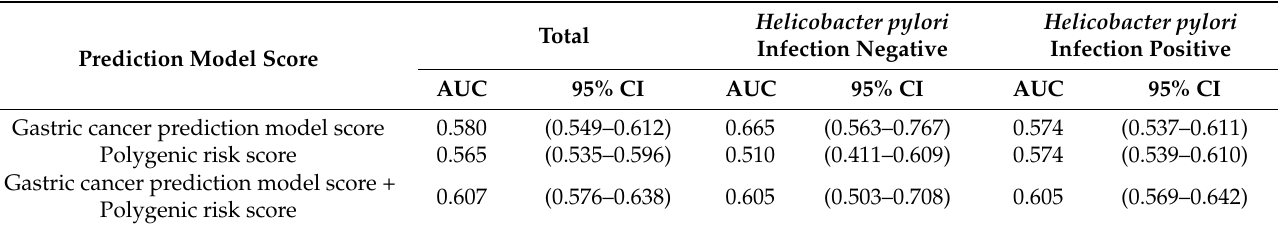
Table 4. Area under the receiver operating characteristic curve for risk